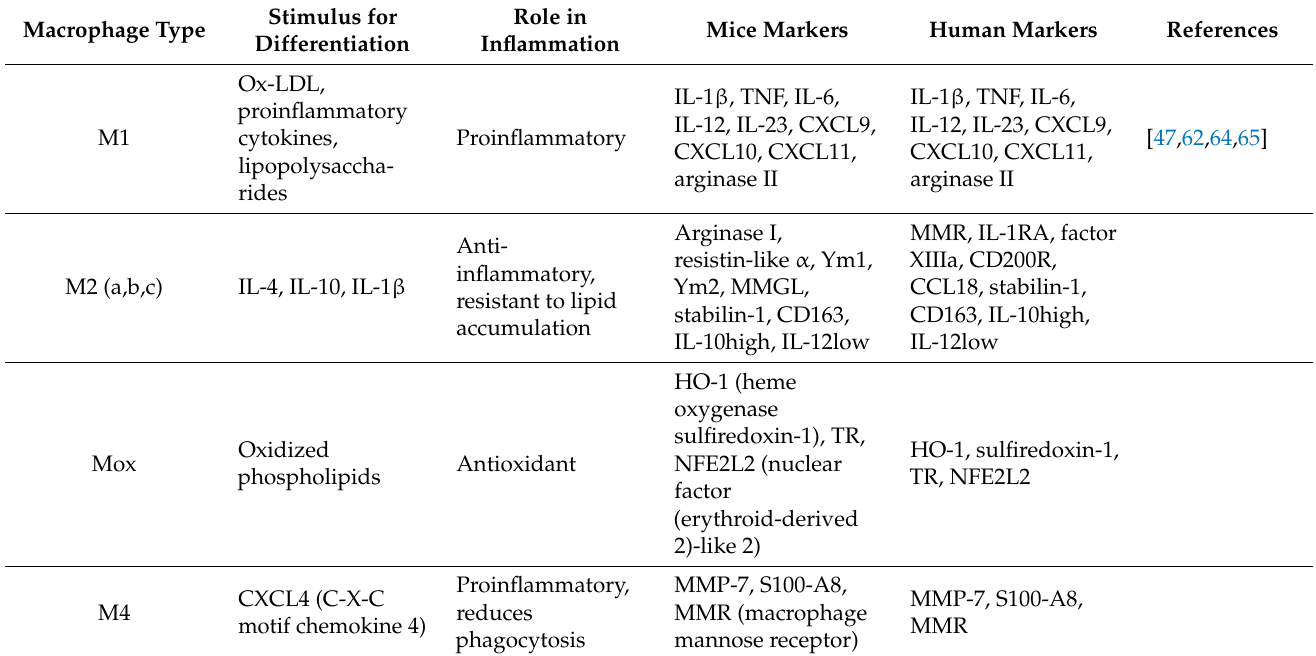
Table 2. Macrophage types and